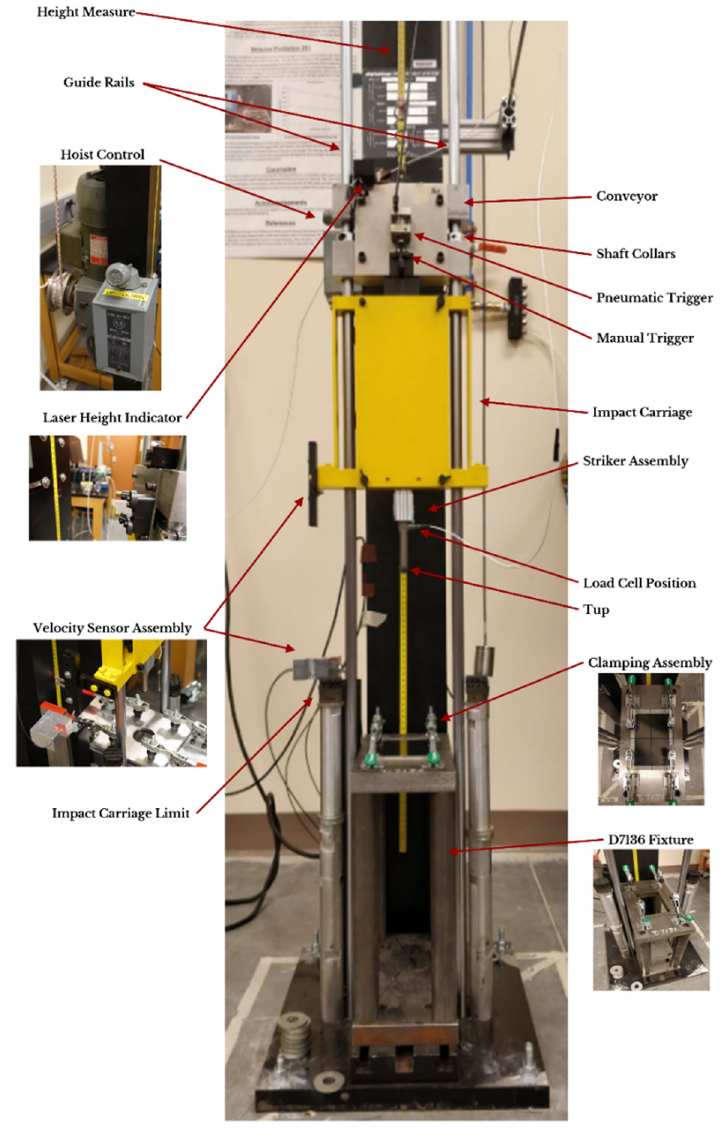
Figure 4. Dynatup 8200 drop weight impact testing machine instrumented with load cell and velocity sensor.